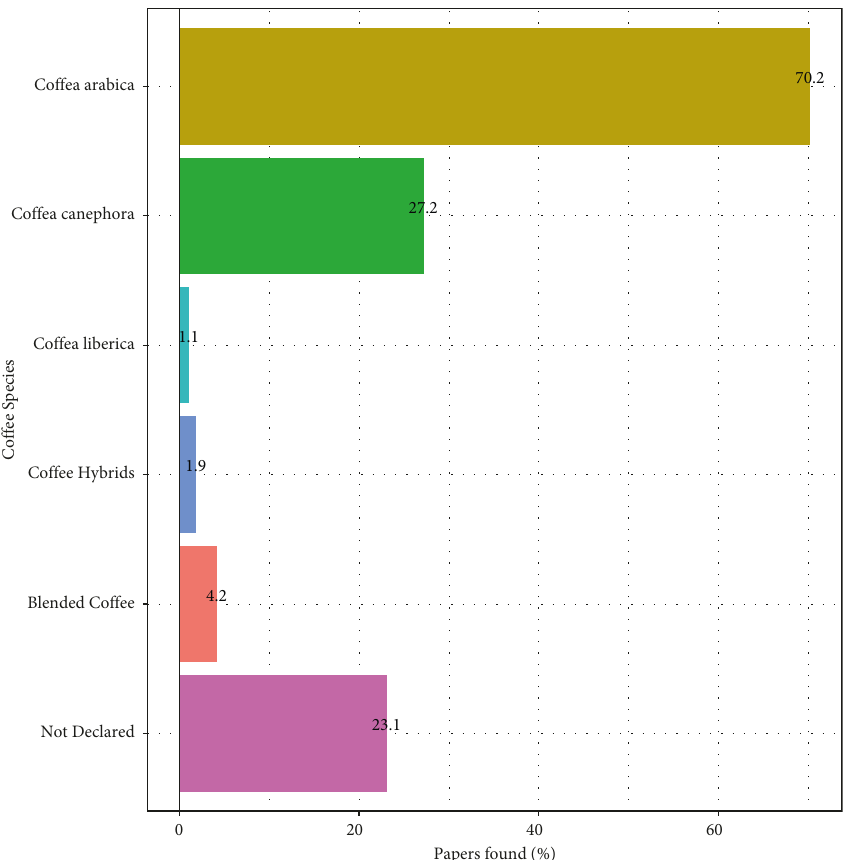
Figure 6: Percentage of the articles classified by the type of coffee species.